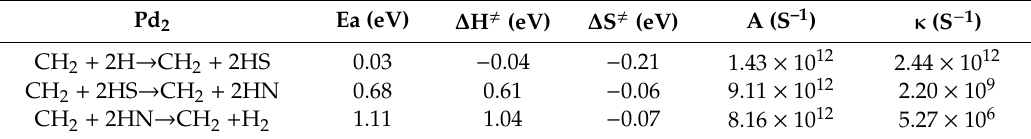
Table 4. The activation energy (E a ), difference enthalpy between the transition state and the initial state ( Δ H ≠ ), difference entropies between the transition state and the initial state ( Δ S ≠ ), pre-exponential factor (A), rate constant ( κ ) for methane activation on Pd 2.